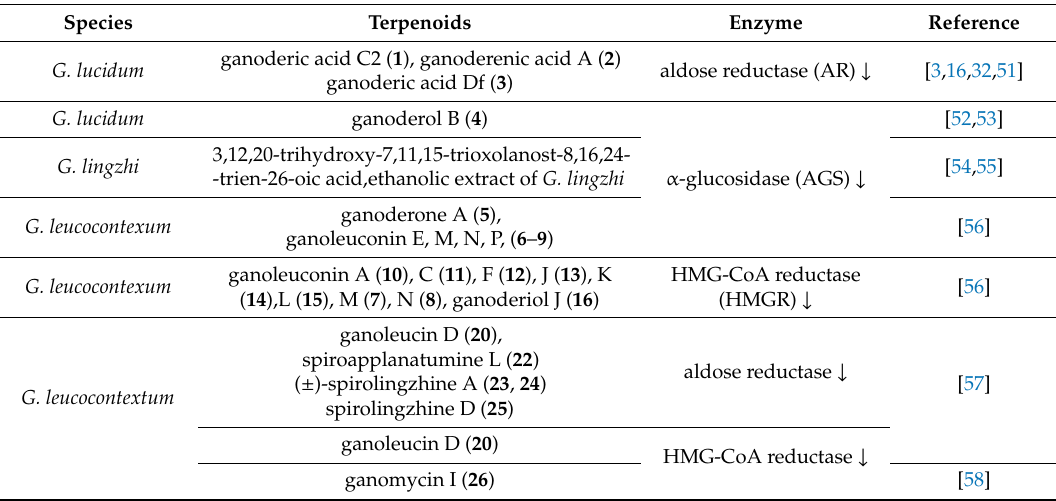
Table 3. Antidiabetic activity of Ganoderma